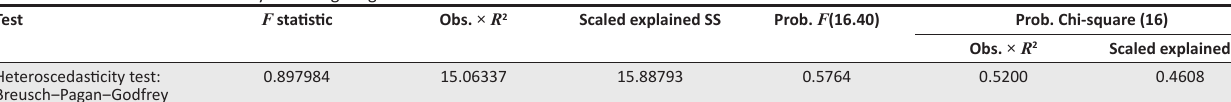
TABLE 7: Test for heteroschedaticity for Mangaung.